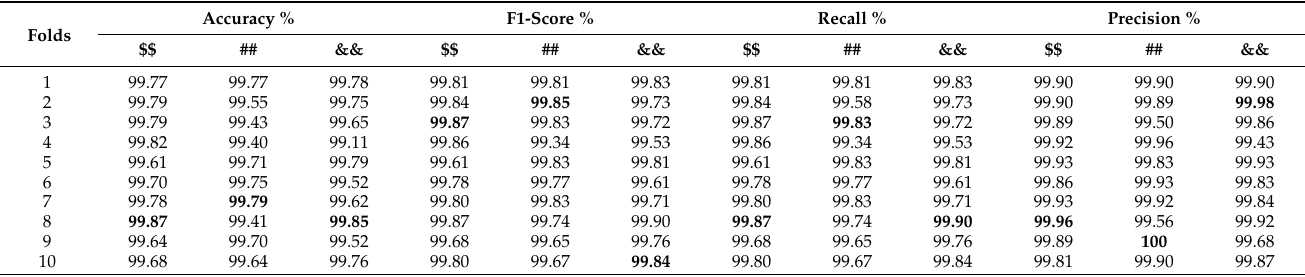
Table 3. Result of 10-fold cross-validation.